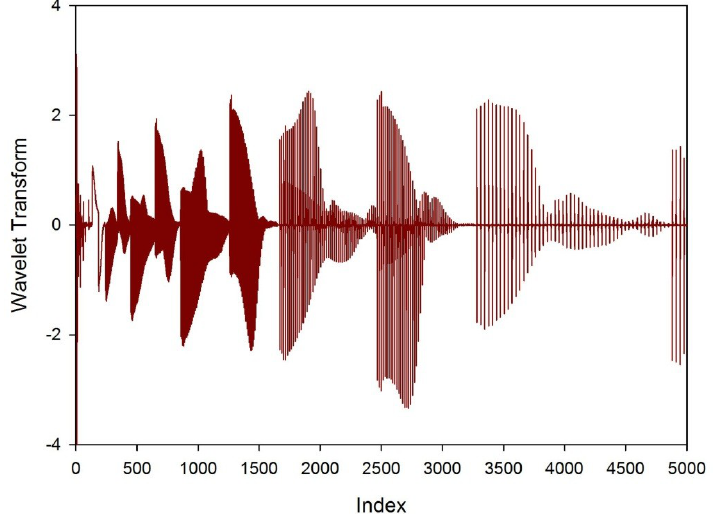
Figure 3. Wavelet transform of a low toxicity patient for elements 1 to